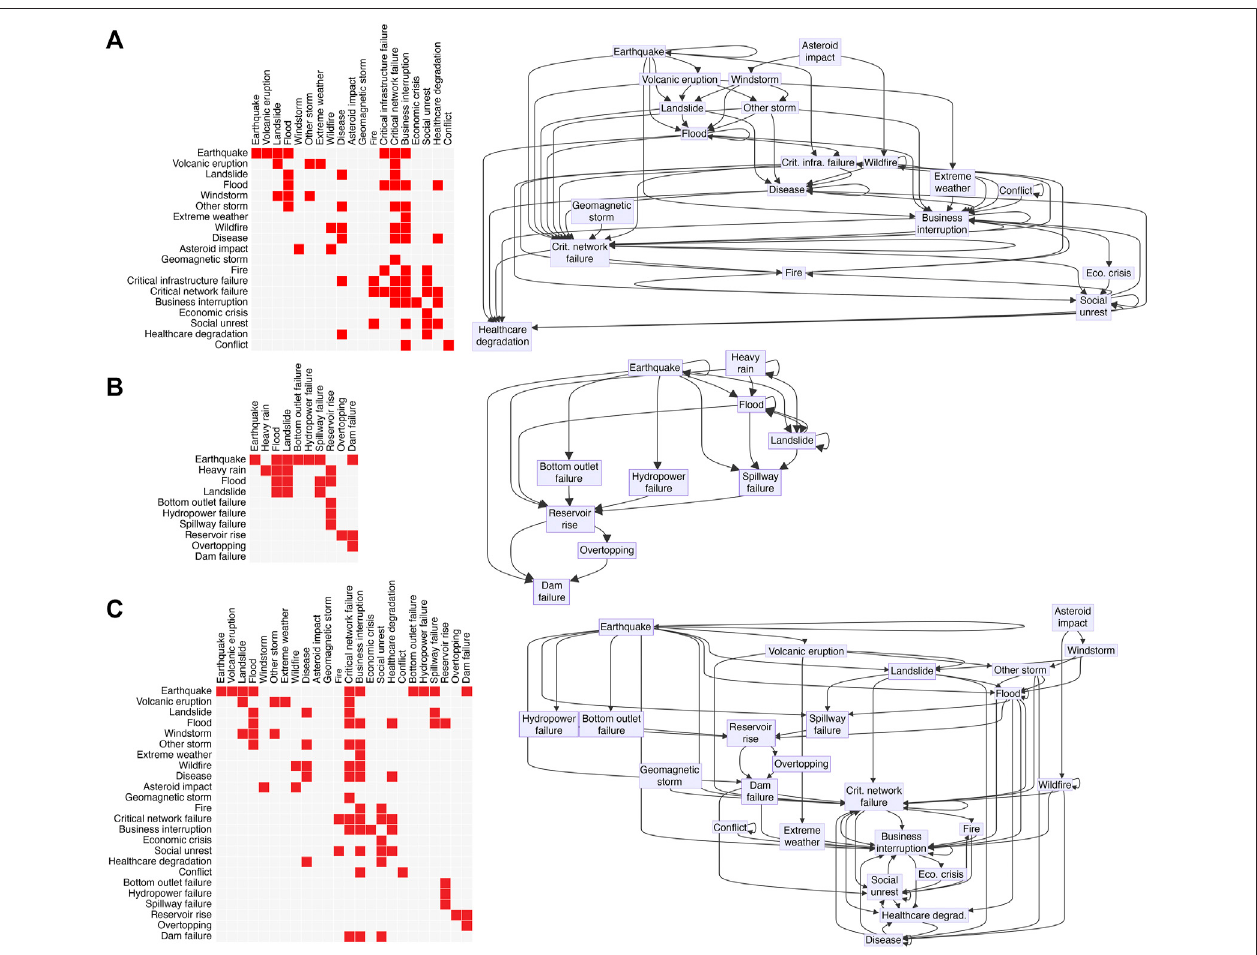
FIGURE 2 | Examples of generic adjacency matrices and matching graphs. (A) Generic interactions across the natural, technological, and socio-economic systems, globally (encoding from Mignan & Wang, 2020); (B) Generic interactions at a hydro-dam, a local critical infrastructure (encoding from Matos et al., 2015); (C) Interactions at both macro- and micro-scales merged into one adjacency matrix. All plots as screenshots from the prototype platform (with font size increased for the present fi gure).